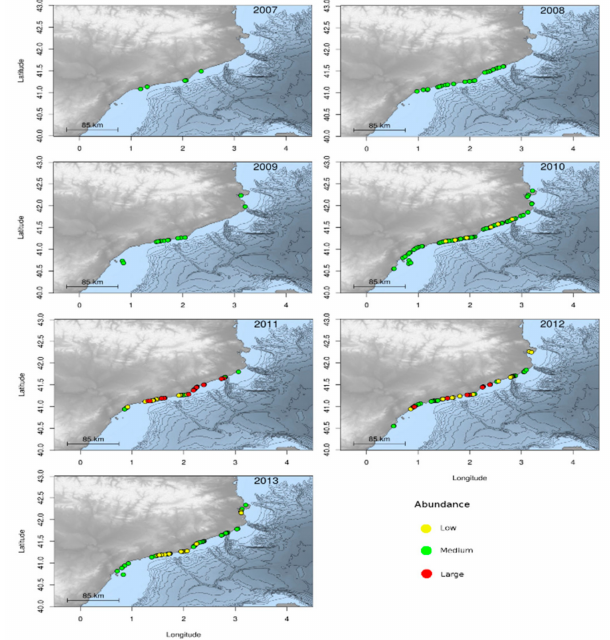
Figure 10. Spatial distribution of jellyfish reports from 2007 (upper-left panel) to 2013 (lower-left panel) for Rhizostoma pulmo in Spain. Abundance categories are shown as follows: category 1—“low” in yellow, category 2—“medium” in green, and category 3—“high” in red. In the case of the Tunisian coastal areas, the northern part (near Bizerte) was the area from where most reports originated. Thus, blooms of P. noctiluca (Figure 11) and R. pulmo (Figure 12) were mostly recorded in this area.